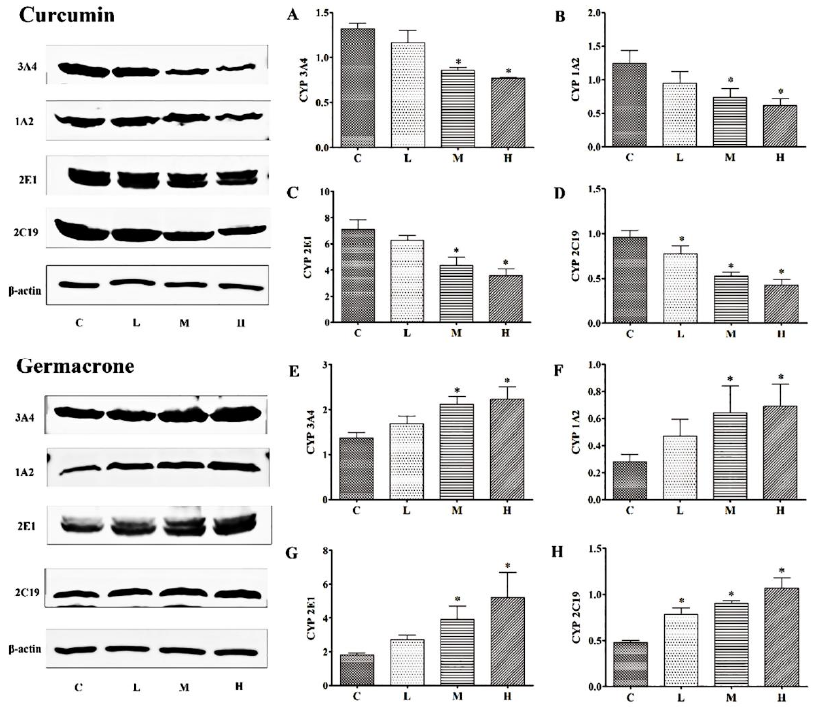
Figure 9. The expression levels of CYP3A4 ( A ), 1A2 ( B ), 2E1 ( C ) and 2C19 ( D ) were decreased in curcumin groups and CYP3A4 ( E ), 1A2 ( F ), 2E1 ( G ) and 2C19 ( H ) were increased in germacrone groups in vivo (mean ± SD, n = 6, *p < 0.05 vs. control rats).